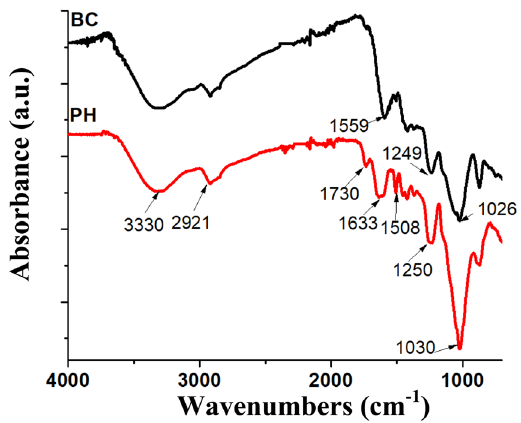
Figure 5. FTIR spectra for peanut hulls (PH) and 500 °C peanut hull biocarbon (BC).